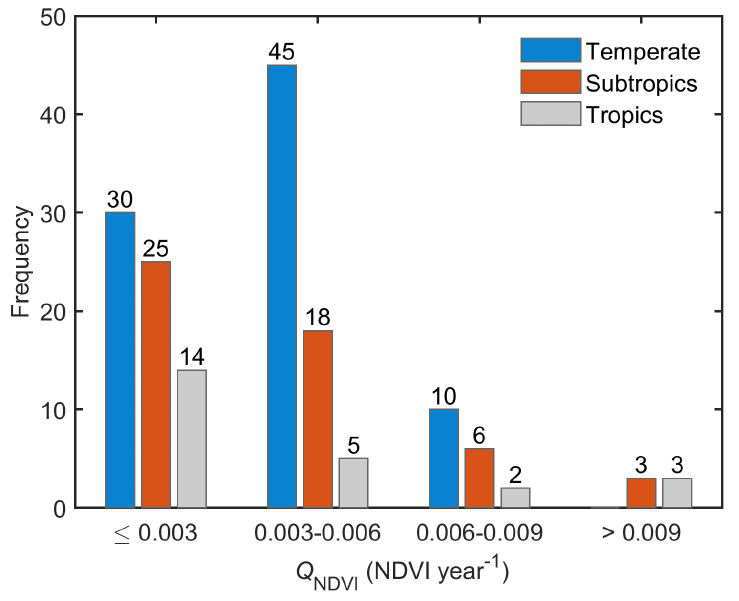
Figure 6. The frequency of various classes of Sen’s slope, Q NDVI , for different latitudes (temper- ate, between 35 ◦ and 66.5 ◦ ; subtropics, between 23.5 ◦ and 35 ◦ ; and tropics, between 0 ◦ and 23.5 ◦ north/south latitudes).